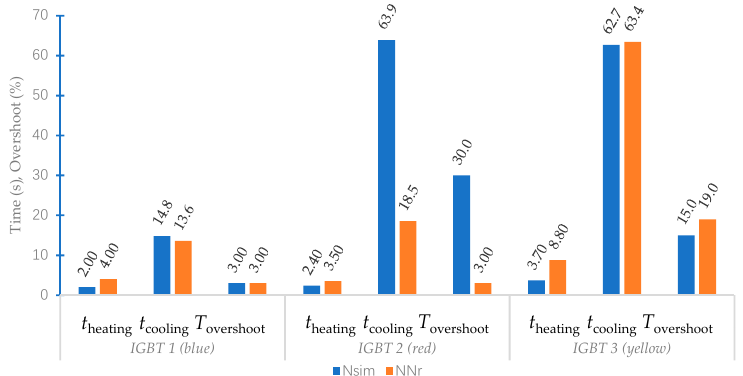
Figure 15. Nsim and NNr temperature characteristics comparison chart.